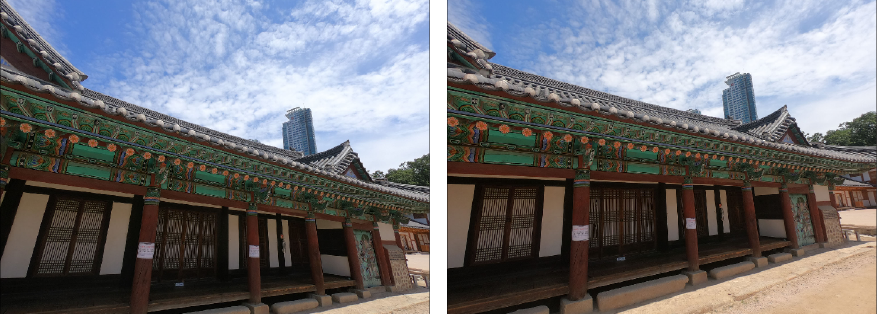
Figure 1. An example of low in-class variability that similar images in the same class. The images are Bongeunsa temple in Seoul, Korea. (Source: Korean Type Object Image AI Training Dataset at http://www.aihub.or.kr/aidata/132, National Information Society